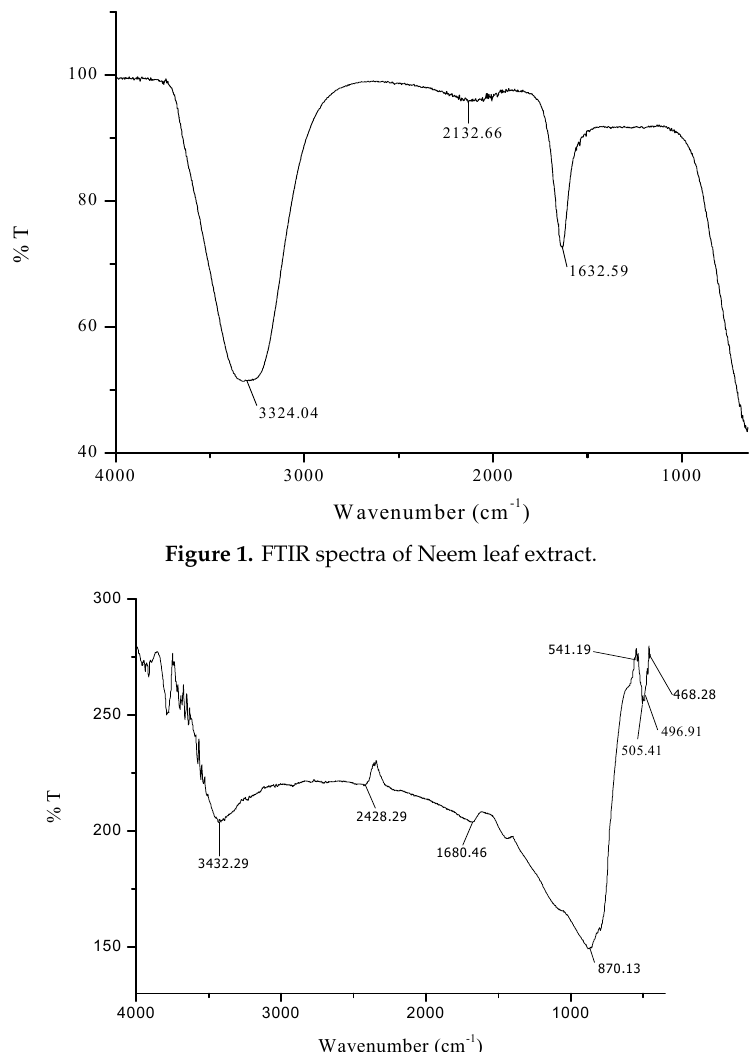
Figure 2. FTIR spectra of synthesized iron oxide nanoparticles.